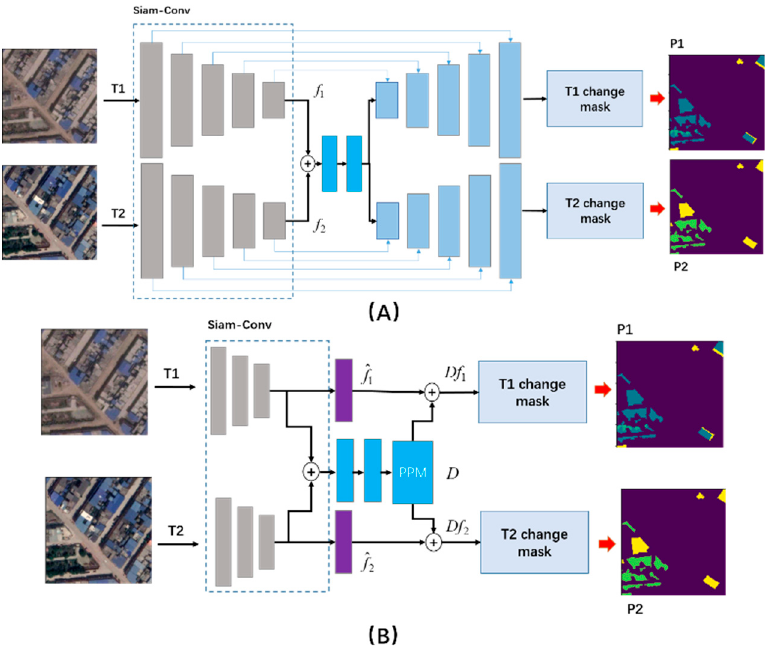
Figure 2. General networks for SCD: ( A ) is the UNet-based SCD network, and ( B ) represents the PSPNet-based SCD network.